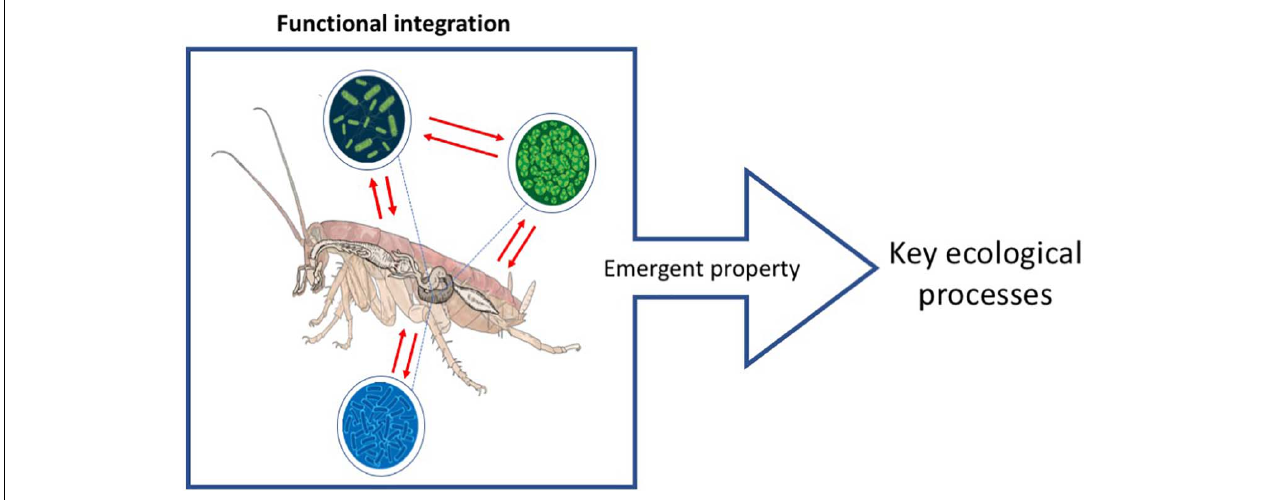
FIGURE 1 | Ecosystem holobiont. The red lines show the functional integration between bionts resulting in the development of emergent properties with ecosystemic functions. For the case of the ecosystem holobiont, these properties are key ecosystem process such as the sustaining of nutrient cycling. Scheme based on the proposals of Catania et al. (2016) and Suárez